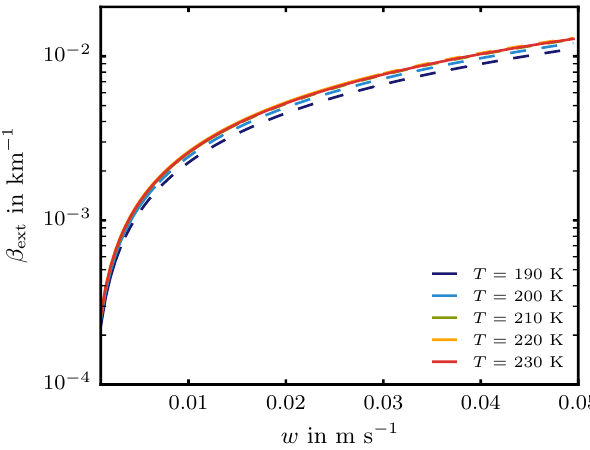
Figure 12. Extinction coefficient at x 0 for different temperatures in the stable focus state 1 (solid lines) and the limit cycle state 2 (dashed